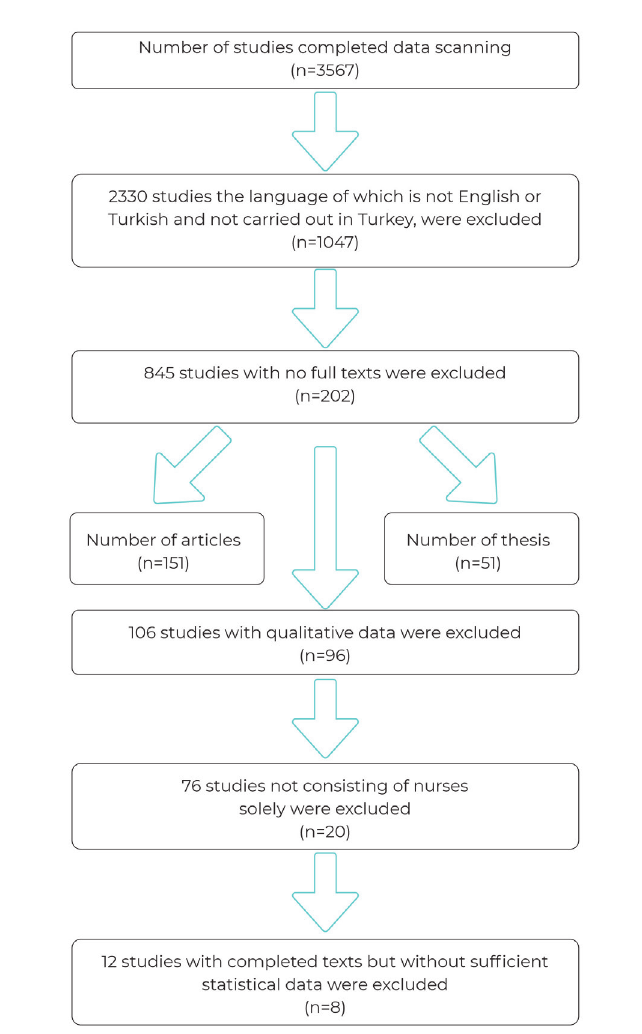
Figure 1 - Process of collecting research